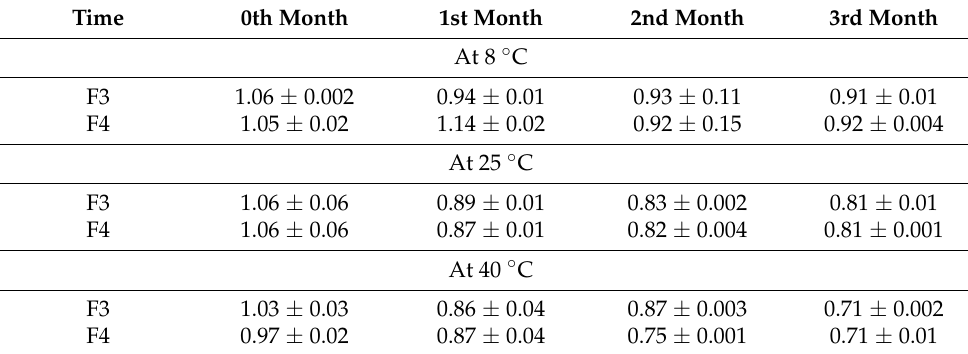
Table 9. Drug stability study of F3 and F4 over 3